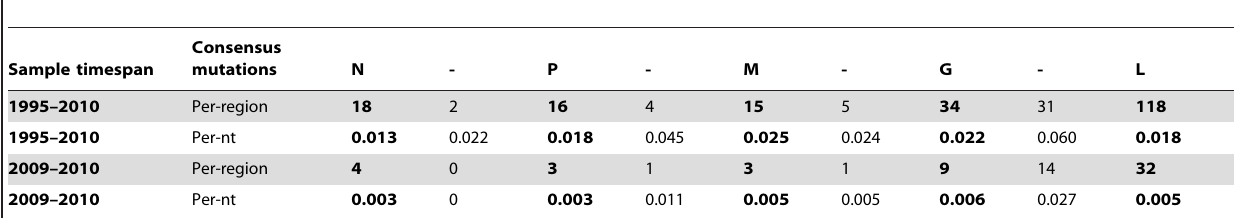
Table 1. Consensus-level mutations found in 5 coding and 4 non-coding regions of the rabies genome.